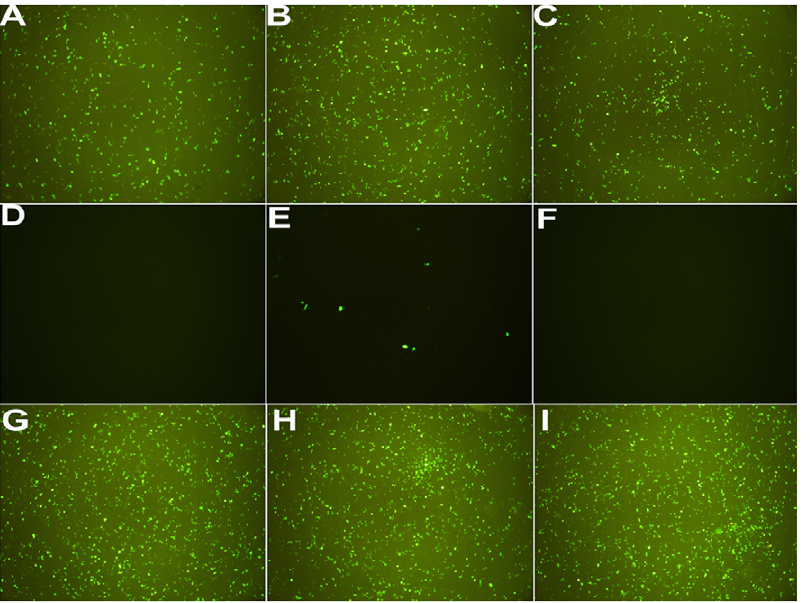
Figure 6. Representative fluorescent microscope images (40 6 ) of A549 cells transfected by L1 at N/P ratio of 1.5 (A), 2 (B), 2.5 (C), L2 at N/P ratio of 2 (D), 2.5 (E), 3 (F) and L3 at N/P ratio of 8 (G), 10 (H), 12 (I). The lipid/DOPE ratios were 1 : 1 and the concentration of DNA was